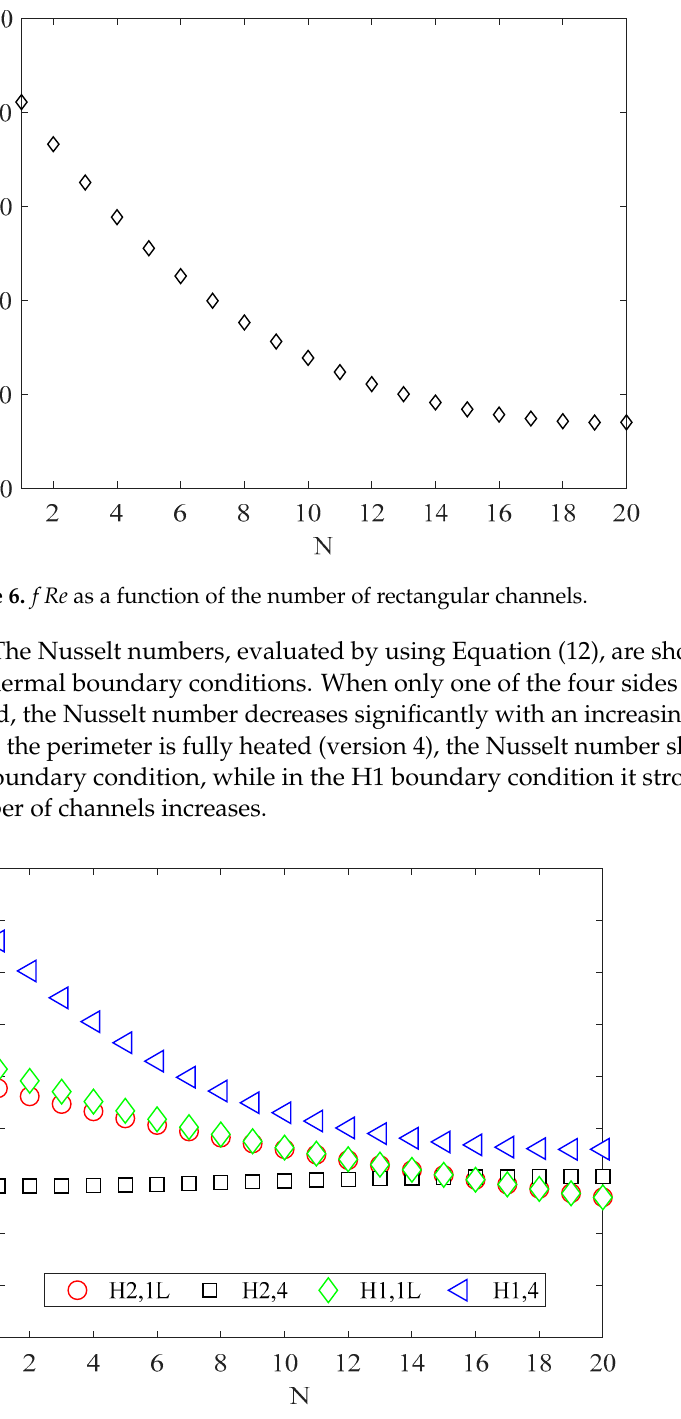
Table 2. Comparison between present results (i.e. Equation (12)) and data available in the litera- ture.